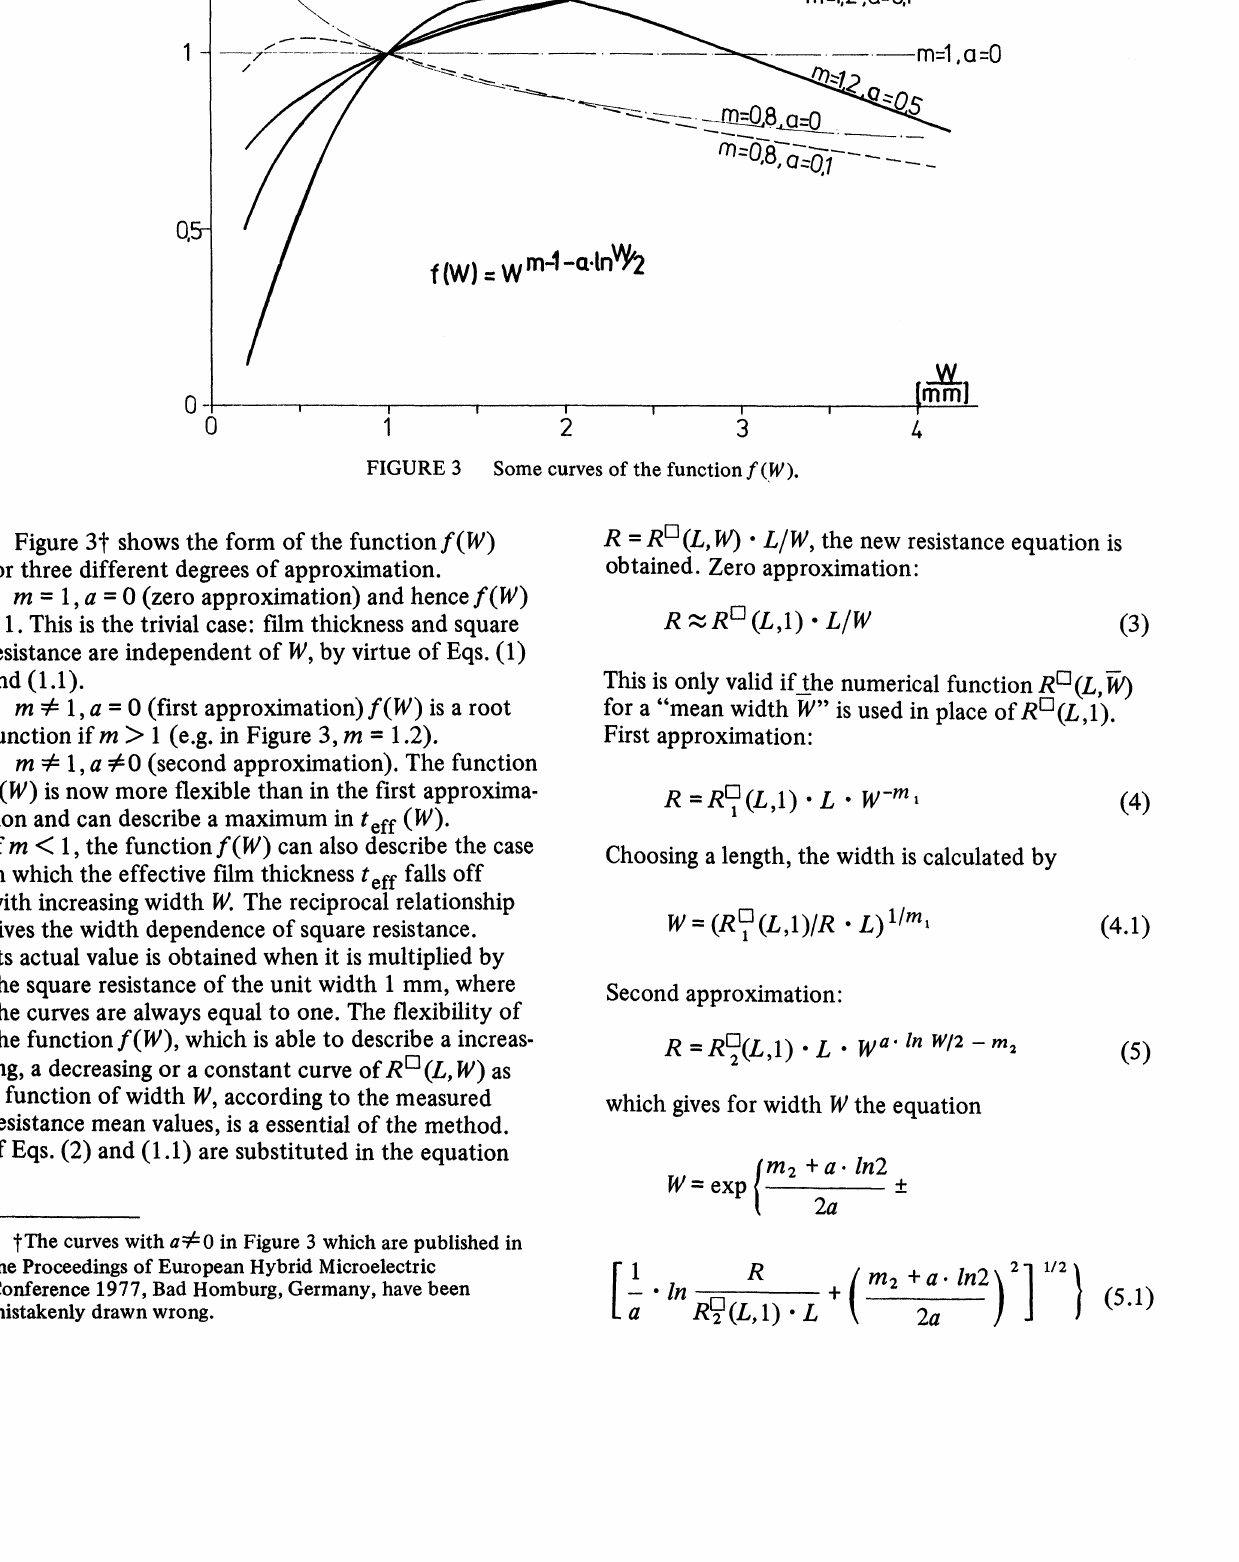
2 3 FIGURE 3 Some curves of the function